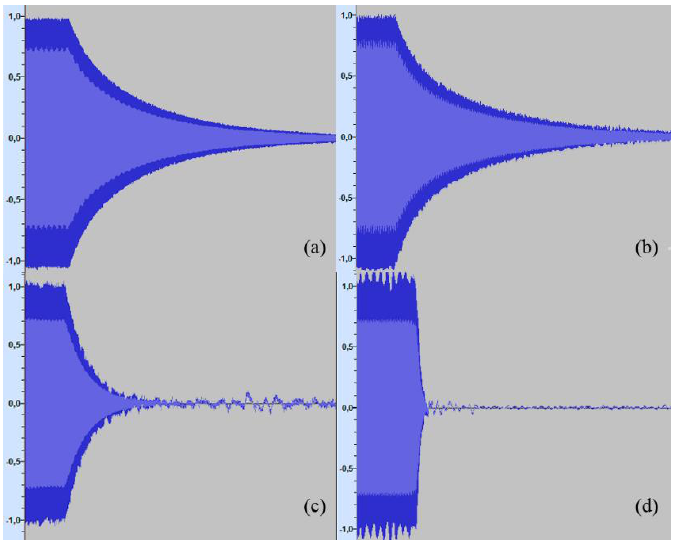
Figure 11. Comparison of the loss factor for CFRE prepregs processed by autoclave and vacuum bag-only.